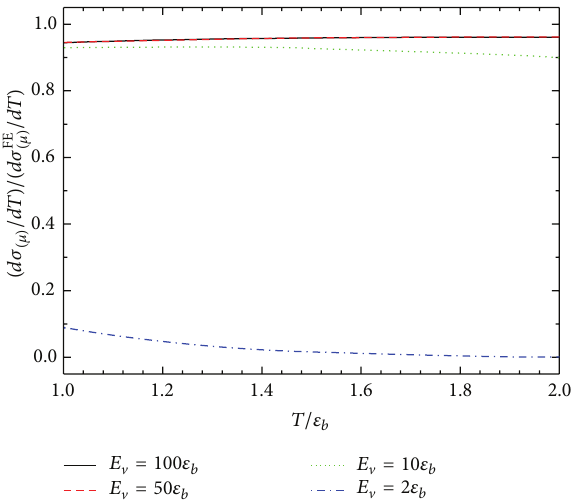
Figure 3: The ratio of single-differential cross sections for magnetic neutrino scattering from the 1𝑠 hydrogen-like and free-electron states, respectively, versus 𝑇/𝜀 𝑏 at different values of 𝐸 ] . The 𝐸 ] = 𝐸 = 100𝜀 50𝜀 𝑏 and ] 𝑏 curves are practically